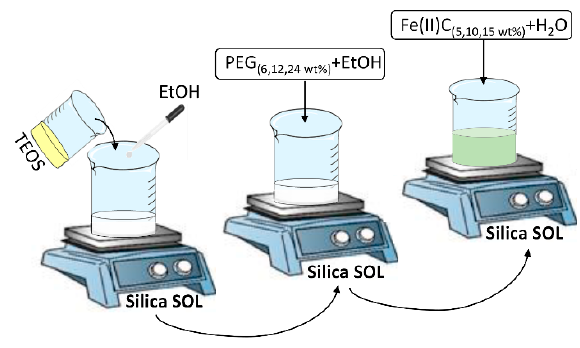
Figure 1. Flow chart of sol-gel synthesis.